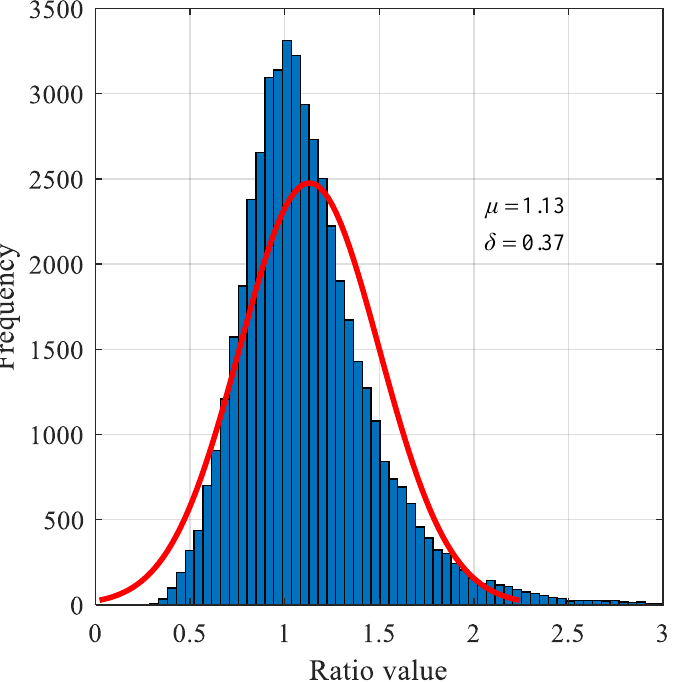
Figure 5. The histogram (blue bars) and the fitted normal density function curve (red line) of samples selected in the zone “ T ” (16 by 21 pixels) are shown in Figure 3. Note: µ and δ represent the mean and standard deviation, respectively.